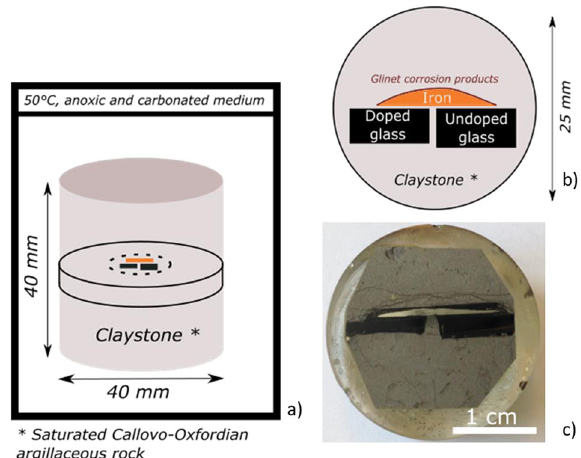
Fig. 1 Experimental setup of the glass/iron/claystone system. Arrangement of the two SON68 glass coupons pressed against a